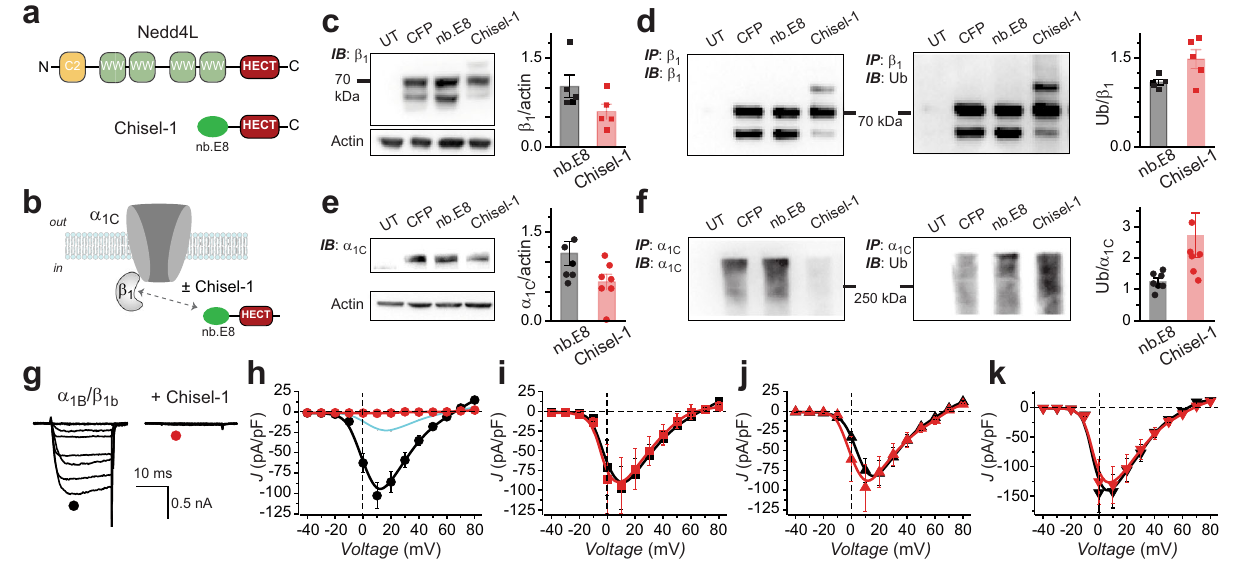
Fig. 6 | Chisel-1 selectively eliminates recombinant Ca V 2.2 channels recon- stituted with Ca V β 1 . a Schematic showing modular structures of Nedd4L and Chisel-1. b Schematicof α 1C + β 1b ±Chisel-1. c Left, β 1b immunoblotinuntransfected cells (UT), or cells transiently transfected with α 1C + β 1b and CFP, nb.E8 or Chisel-1. Right, Bar charts showing impact of Chisel-1 on normalized β 1b expression ( n =5 independent experiments each for CFP, nb.E8, and Chisel-1 groups). d Left, β 1b pulldown followedby β 1b immunoblot. Middle, β 1b pulldown followed byubiquitin immunoblot.Right,BarchartshowingChisel-1enhancesubiquitinationof β 1b ( n =5 independent experiments each for CFP, nb.E8, and Chisel-1 groups). e Left, α 1C immunoblot. Right, impact of Chisel-1 on α 1C normalized expression ( n =6 inde- pendentexperimentseachforCFP,nb.E8,andChisel-1groups). f Left, α 1C pulldown followed by α 1C immunoblot. Middle, α 1C pulldown followed by ubiquitin immu- noblot. Right, Bar chart showing Chisel-1 enhances ubiquitination of α 1C ( n =6 independent experiments each for CFP, nb.E8, and Chisel-1 groups). g Exemplar